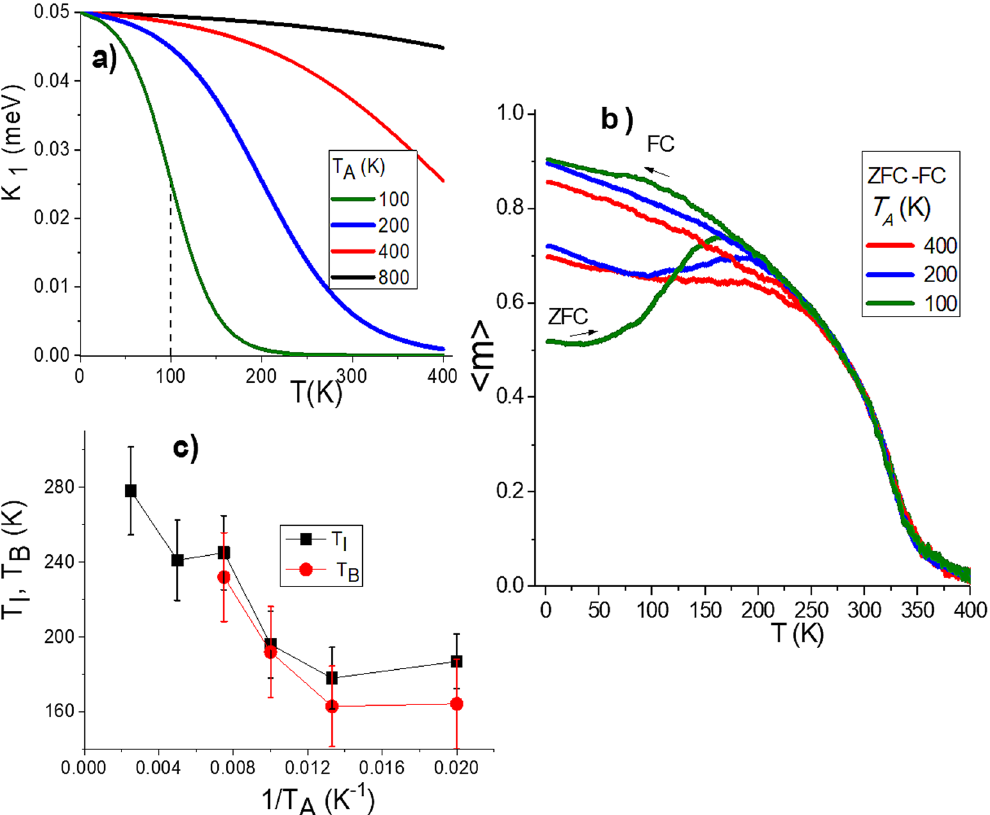
Figure 5. ( a ) Crystalline anisotropy per spin moment as a function of temperature for different values of T according to Eq. (7), the temperature at inflexion point is identified by dash line for = T K 100 T A over three different ZFC-FC curves and ( c ) blocking and irreversibility temperatures presented as function of T 1/ A